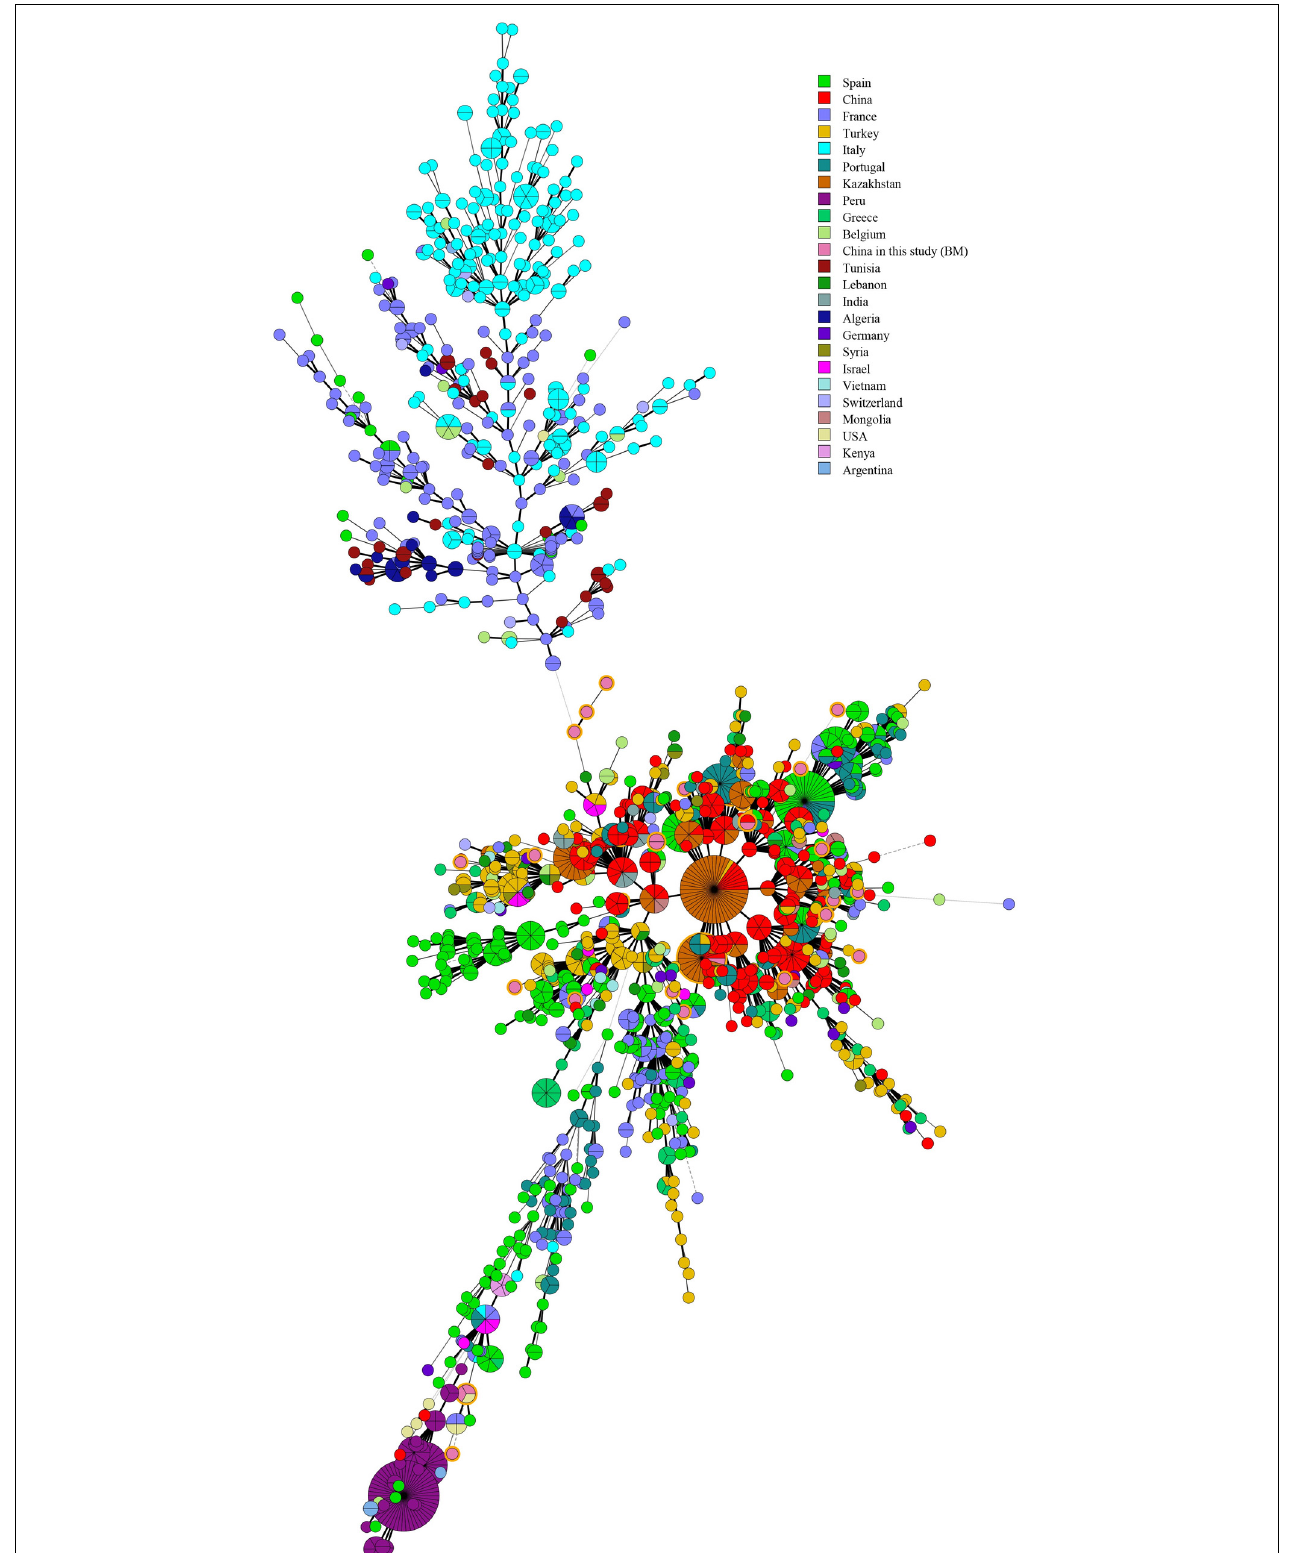
FIGURE 6 | Minimum Spanning Tree characteristics based on global B. melitensis strains.